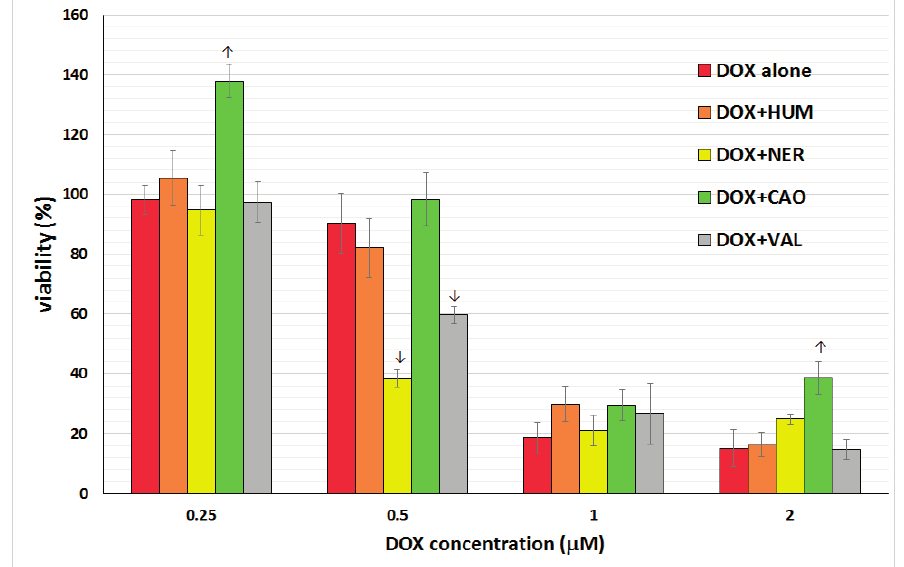
Figure 4. Effect of DOX (0.25, 0.5, 1, 2 µM) and the combinations 0.25 µM DOX + 6.25 µg/mL sesquiterpene, 0.5 µM DOX + 12.5 µg/mL sesquiterpene, 1 µM DOX + 25 µg/mL sesquiterpene, 2 µM DOX + 50 µg/mL sesquiterpene on viability of primary culture of (=100%) represent the mean ± S.D. from 2 independent experiments with 6 parallels in each ( ↑ significant increase; ↓ significant